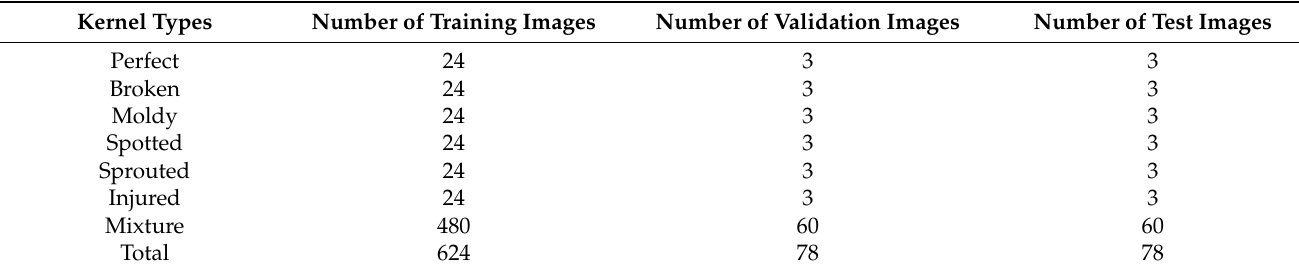
Figure 3. Labeled images of overlapping wheat grain. Table 1. Distribution of the dataset.